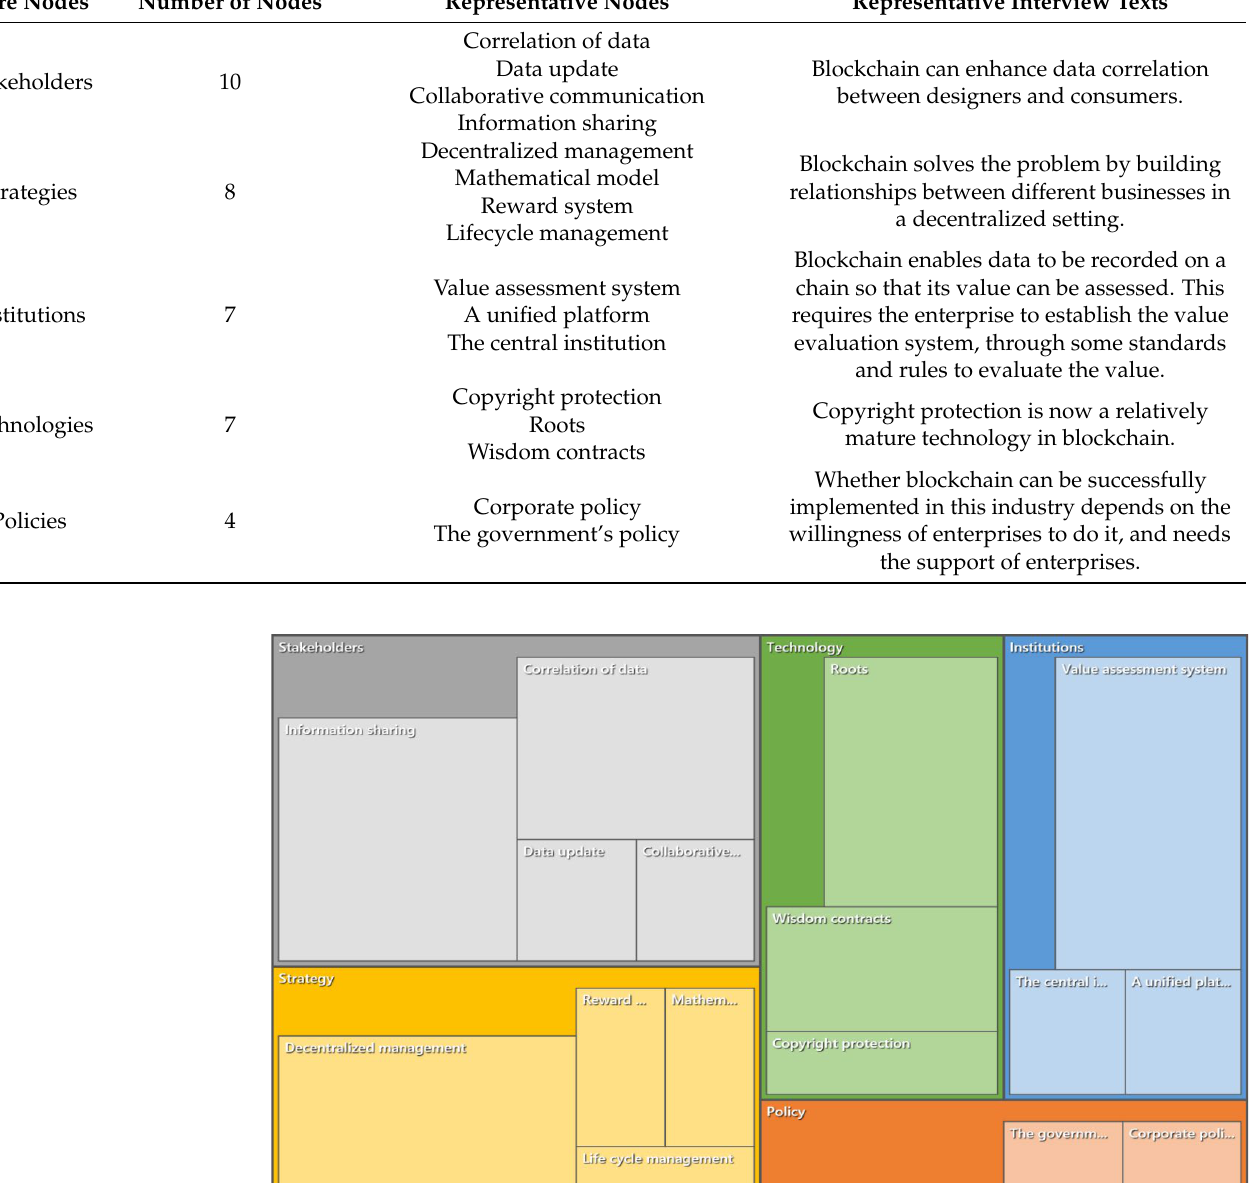
Table 6. The encoding results of the interview transcripts via NVivo 11 software.